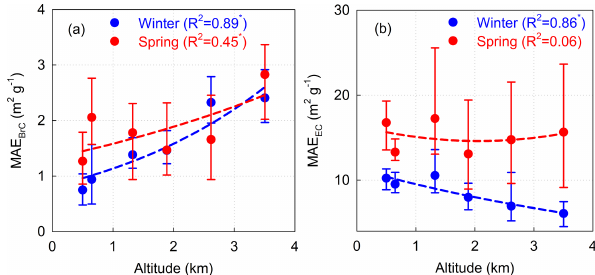
Figure 4. Variations of (a) MAE BrC and (b) MAE EC at 405nm as altitude in spring and winter during the field campaign. The solid dots denote the median values, and the two whiskers of the dots denote the 25th and 75th percentiles. The relationships between av- eraged MAE and altitude of the measurement sites are fitted by an exponential function, and the coefficients of determination ( R 2 ) are also given in each subplot. The relationships ( R 2 with the super- script of an asterisk) pass the significance level of